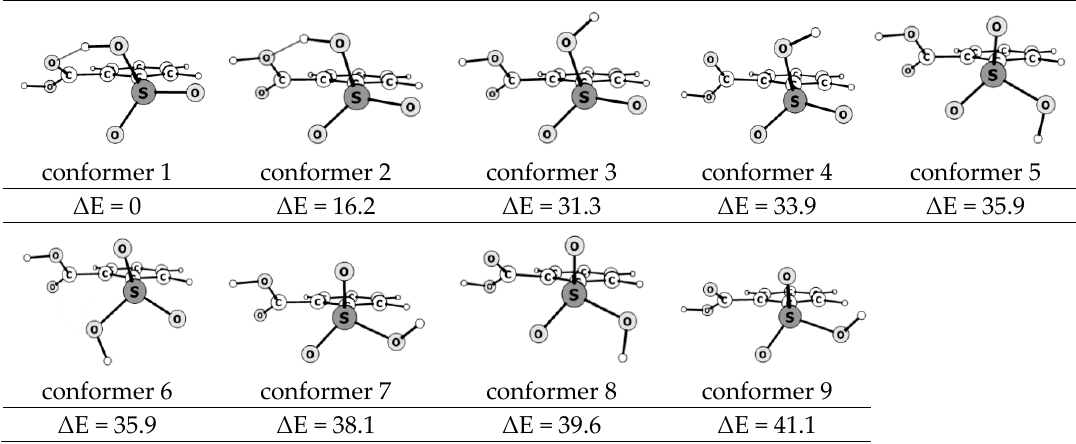
Figure 1. The structure of the 2-COOH-BSA conformers and their relative energies ( Δ E, kJ mol − 1 ).